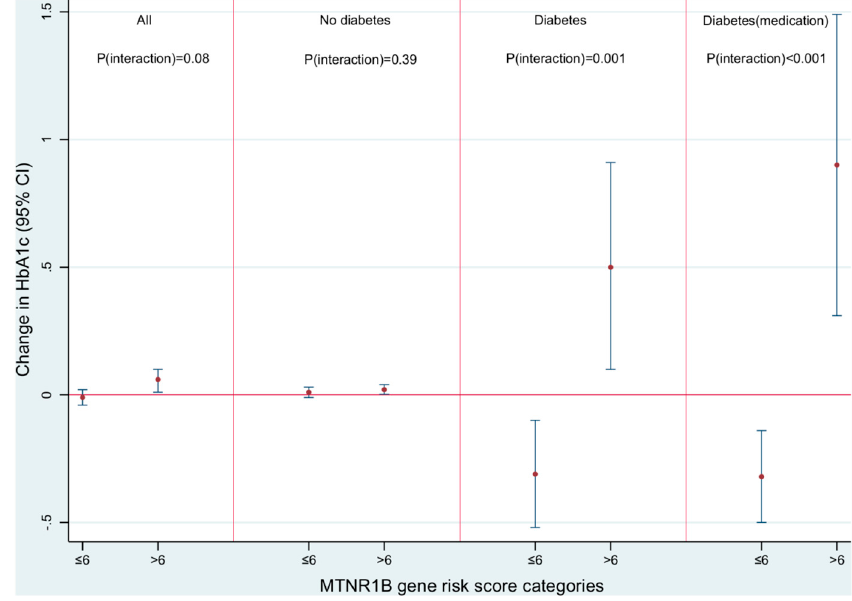
Figure 2. Modification of the association between night ‐ time road traffic noise and change in HbA1c by melatonin dysregulation risk score, in non ‐ movers. by melatonin dysregulation risk score, in